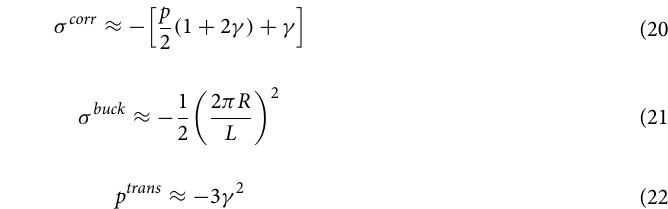
p , σ (cid:31) (cid:30)